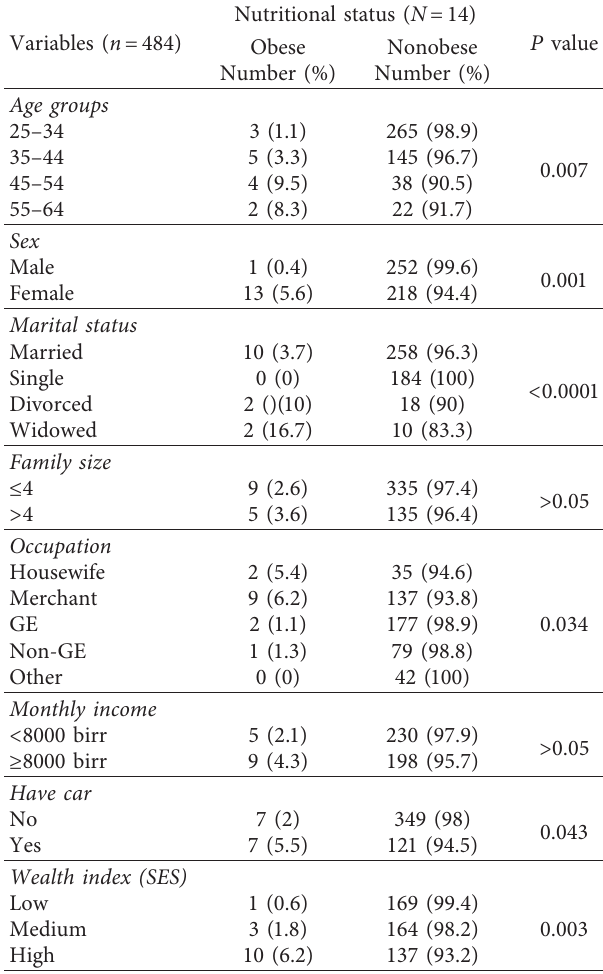
Table 2: Prevalence of obesity by sociodemographic characteristics of study participants in Addis Ababa, Ethiopia.